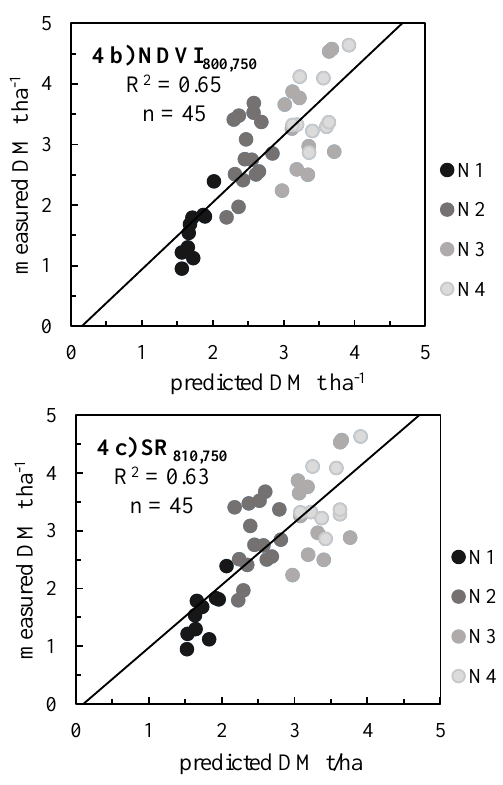
Figure 4 a-c. Cross-validation results for predicted and measured DM t ha -1 from validation subset of VIs derived from the Yara N-Sensor measurements. N1: 0 kg N ha -1 , N2: 50 kg N ha -1 , N3: 100 kg N ha -1 , N4: 150 kg N ha -1